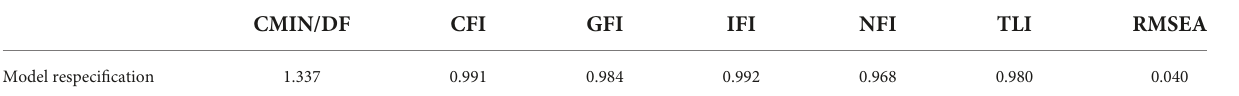
TABLE 3 Model fit